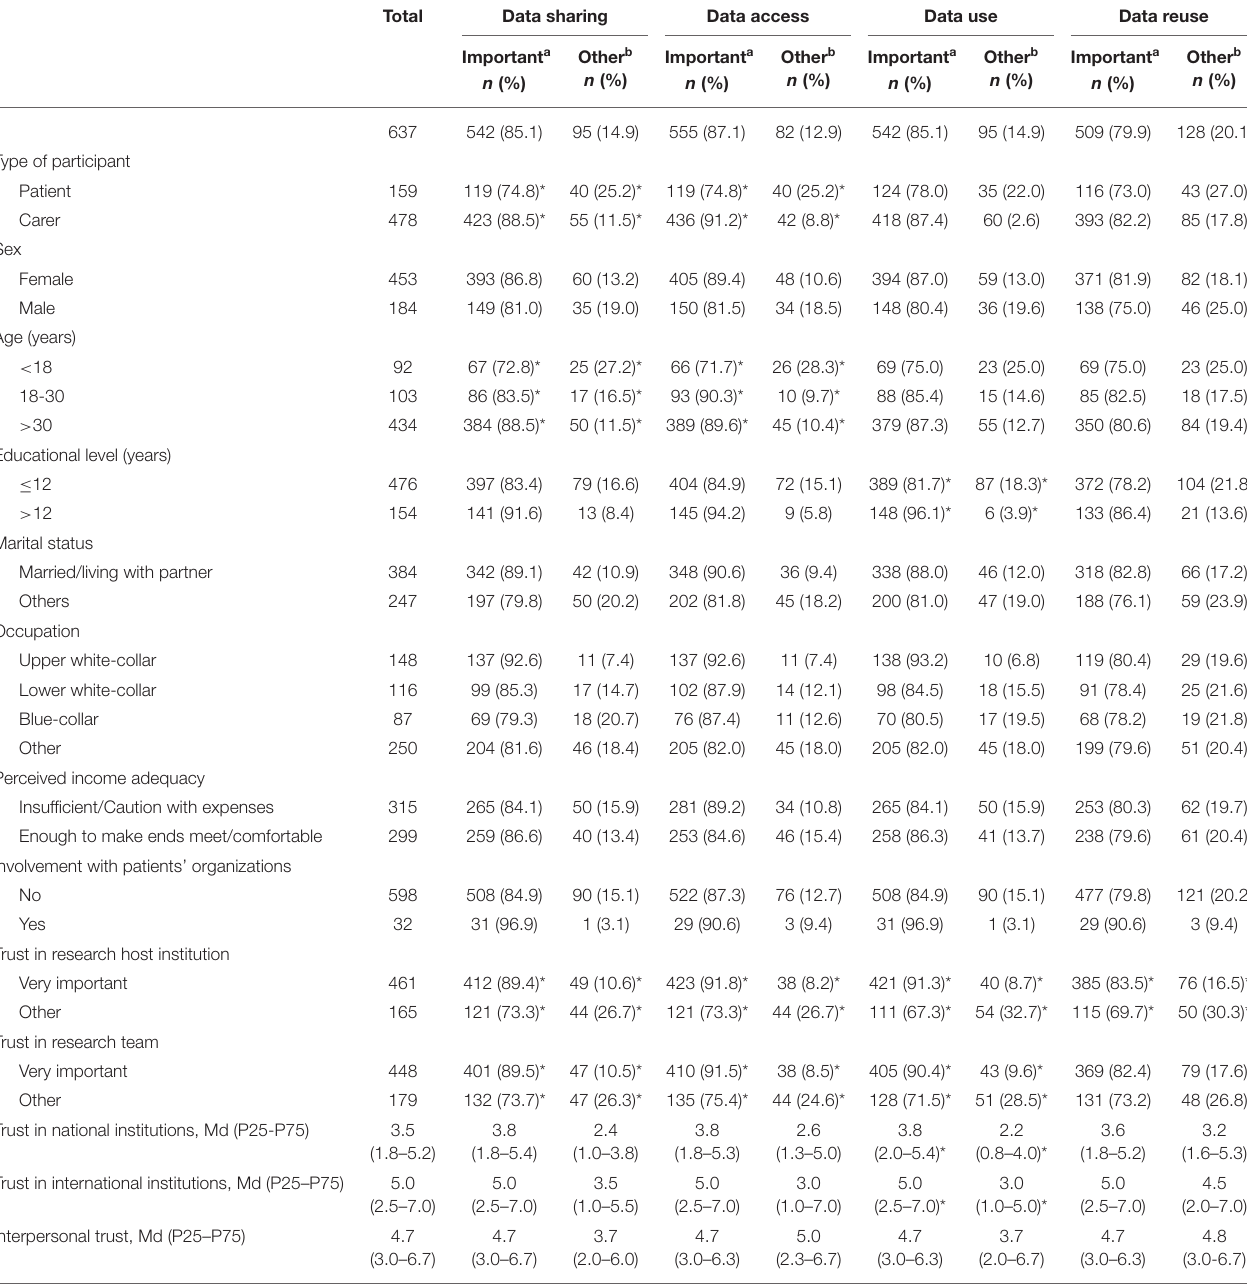
TABLE 3 | Factors influencing participants’ views about involvement in decision-making regarding health data sharing, access, use and